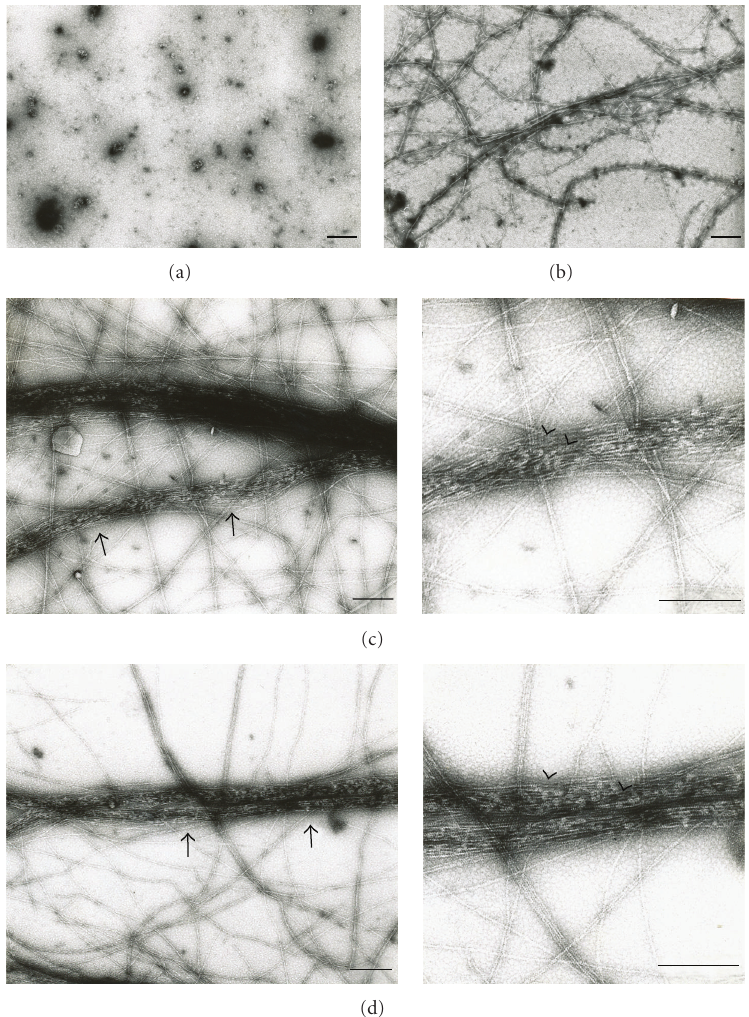
Figure 6: Negative-stained electron micrographs of actin filaments under the influence of purification nebulin. (a) nebulin only, 19 μ g/ml; (b) actin only, 0.2 mg/ml; (c and d) actin (0.2mg/ml) was mixed with nebulin (19 μ g/ml) in 0.11 M KPO 4 , 0.31 M urea, 0.27 mM ATP and 0.1mM MgCl 2 , pH 7.0. Bar, 200